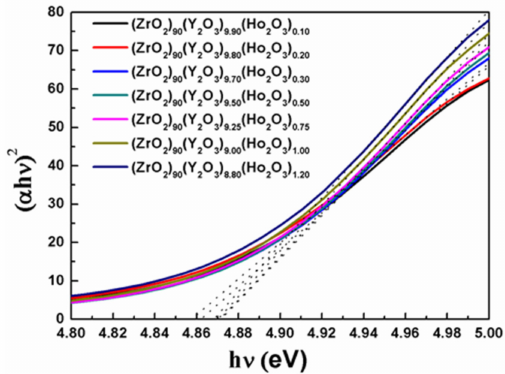
Figure 9. Measurements of the optical bandgap in (ZrO 2 ) 90 (Y 2 O 3 ) 10 − x (Ho 2 O 3 ) x crystal discs. Table 4. Values of intercept, slope, R 2 , and E g for (ZrO 2 ) 90 (Y 2 O 3 ) 10 − x (Ho 2 O 3 ) x . x Slope Intercept R 2 E g (eV)